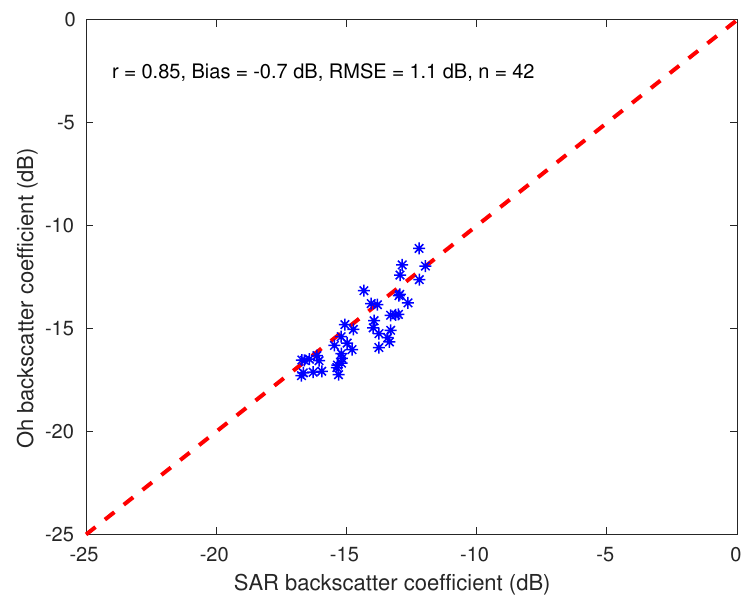
Figure 4. Comparison between backscattering coefficients derived from Sentinel-1 images and those simulated by the Oh 1992 model at VV